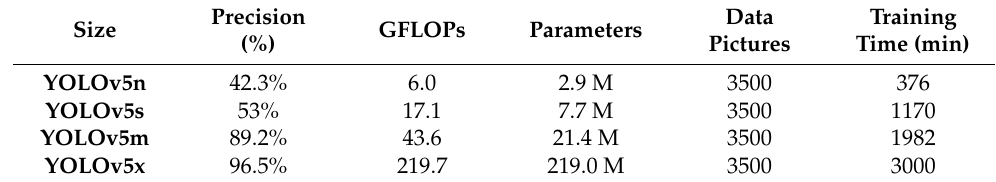
Table 3. Training results of models with different sizes ( − 15 dB mixed radiation source signal).